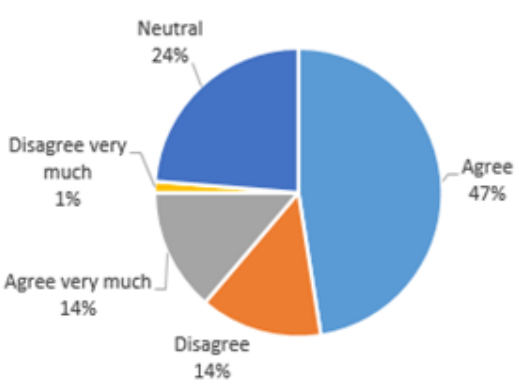
Figure 5. The content of the exams and the work assessed correspond to the contents of the course and